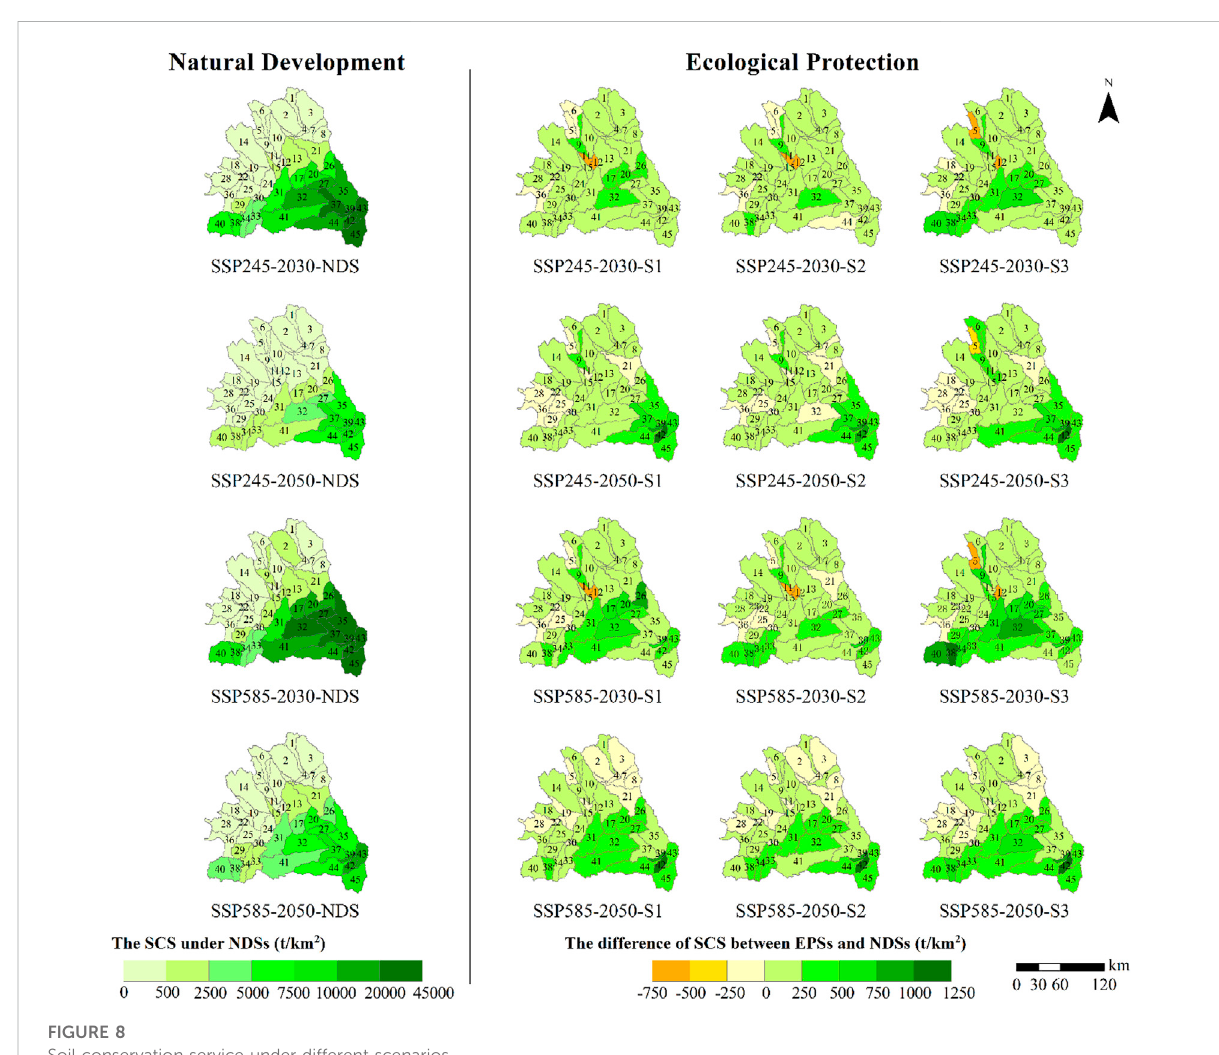
FIGURE 8 Soil conservation service under different